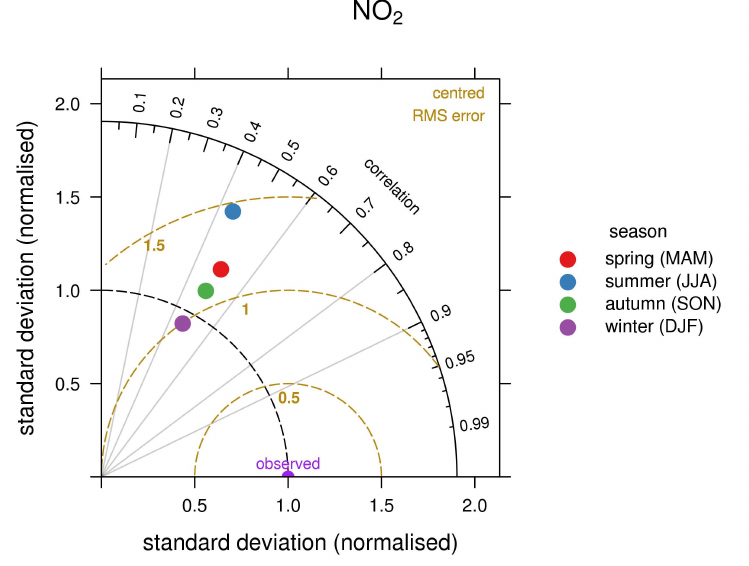
Figure 9. As in Figure 8, but for NO 2